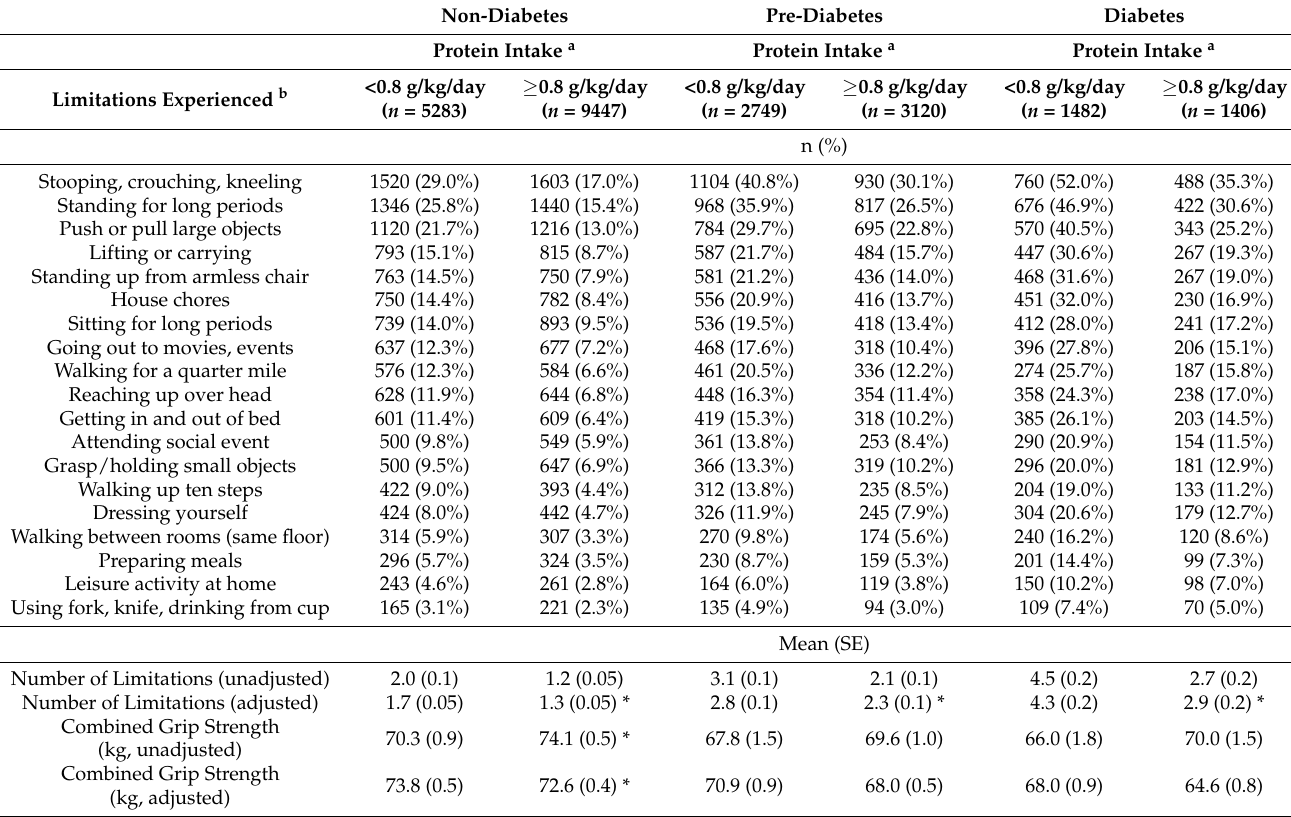
Table 5. Frequency of limitations and grip strength differences across diabetes status in those below or meeting the protein intake